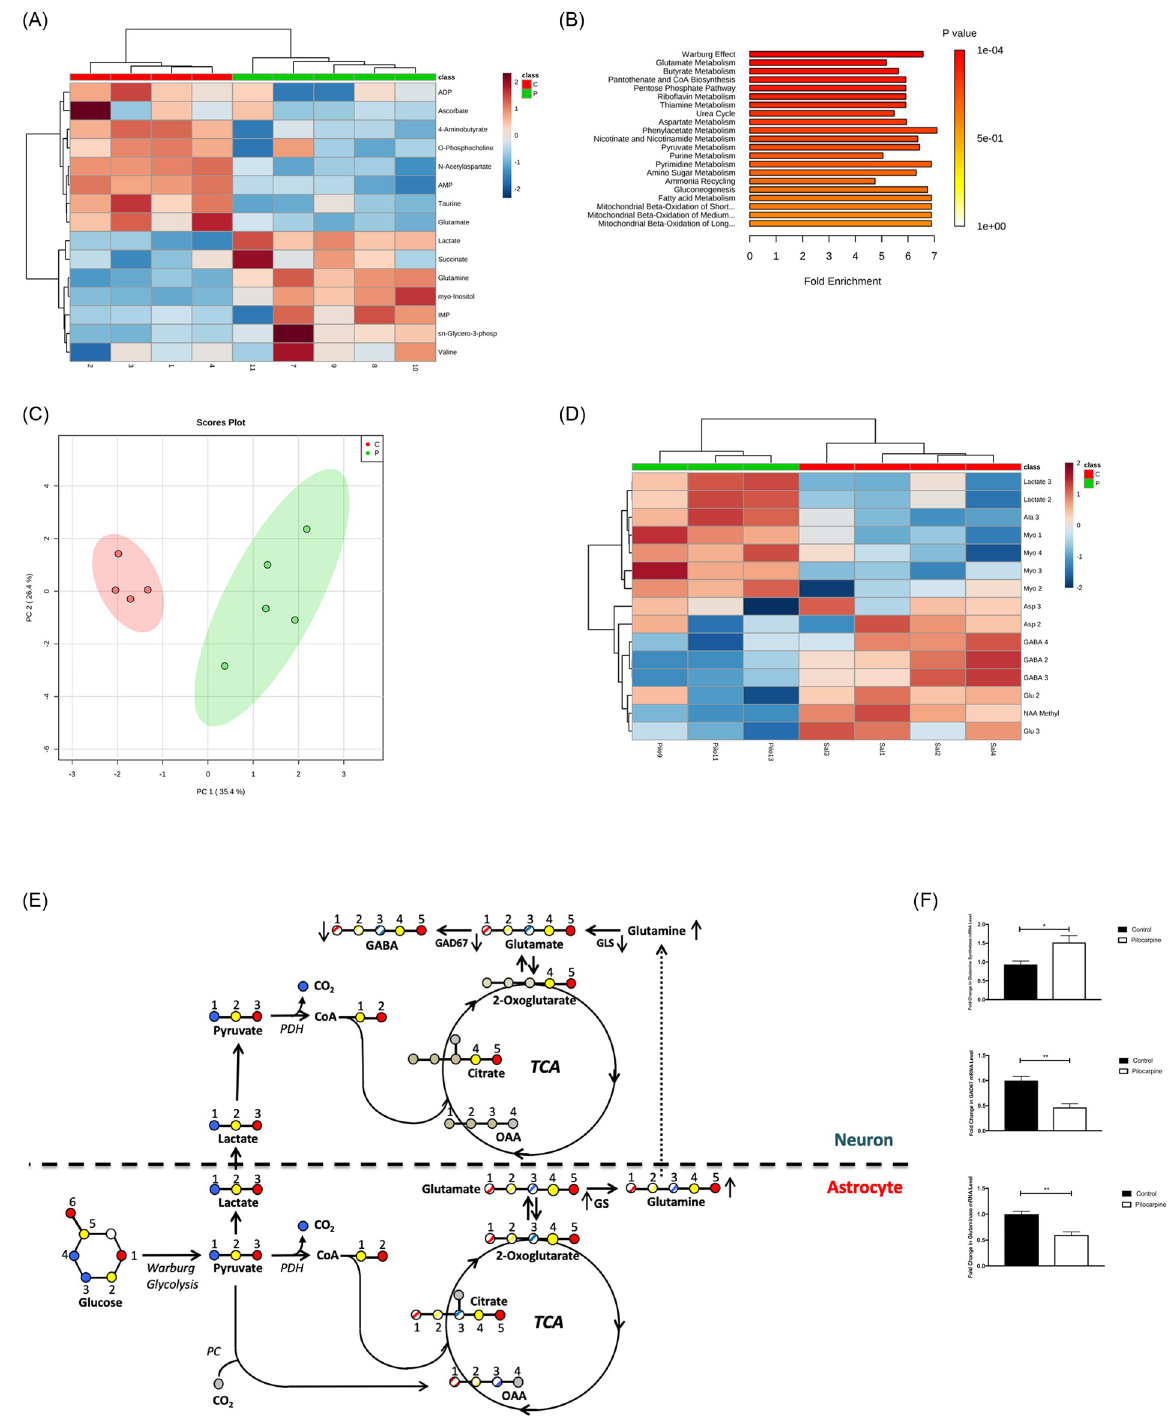
Fig 4. Metabolite analysis reveals elevated lactate and glucose metabolism in 5-day post-SE hippocampal metabolism—Signatures of Warburg metabolism. 4–5 different hippocampi per group were independently processed and analyzed as described in methods. (A) Hierarchical cluster analysis of metabolites consistent with Warburg metabolism (Metaboanalyst 4.0, [62, 63]). The top 15 metabolites by significance are displayed. Metabolites were segregated into two clusters with clear up- and down-changes in metabolites between control and pilocarpine-treated mice. (B) Warburg effect identified by metabolite set enrichment analysis (MSEA, Metaboanalyst 4.0, [62, 63]). The top 20 metabolic pathways enriched in 5-day post-SE hippocampus relative to control were identified by analysis of metabolites from S1 Table using